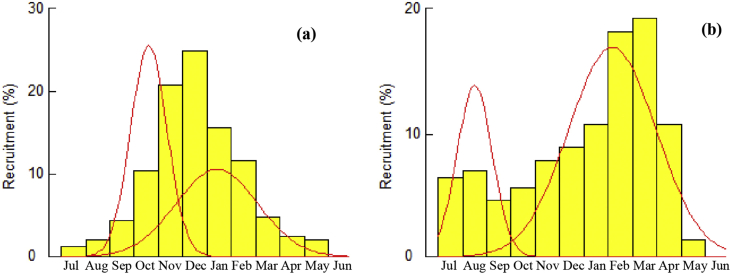
Annual recruitment patterns of (a) male and (b) female S. olivacea sampled from Sundarban mangrove of Bangladesh.